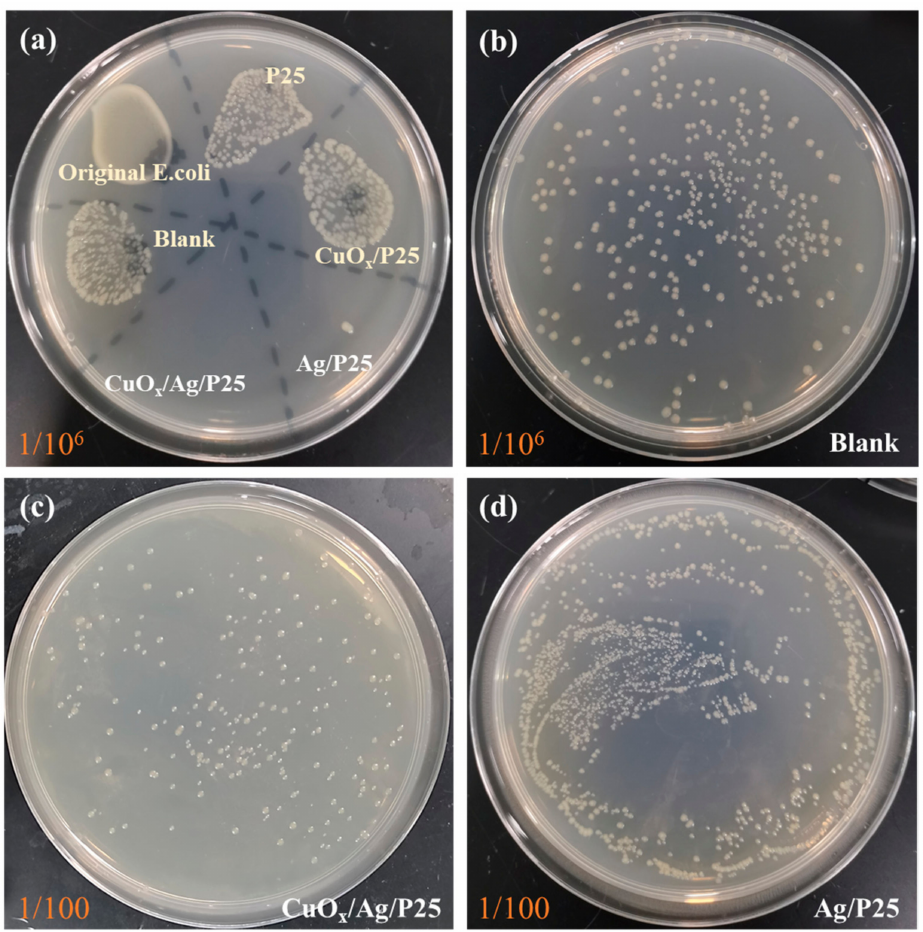
Figure 6. Optical photographs of agar plates coated with different catalysts and E. coli incubated solution with various dilutions: ( a ) comparison of the samples at 1 × 10 6 –times dilution, ( b ) blank sample at 1 × 10 6 –times dilution, ( c ) CuO x /Ag/P25 at 100-times dilution, and ( d) Ag/P25 at 100-times